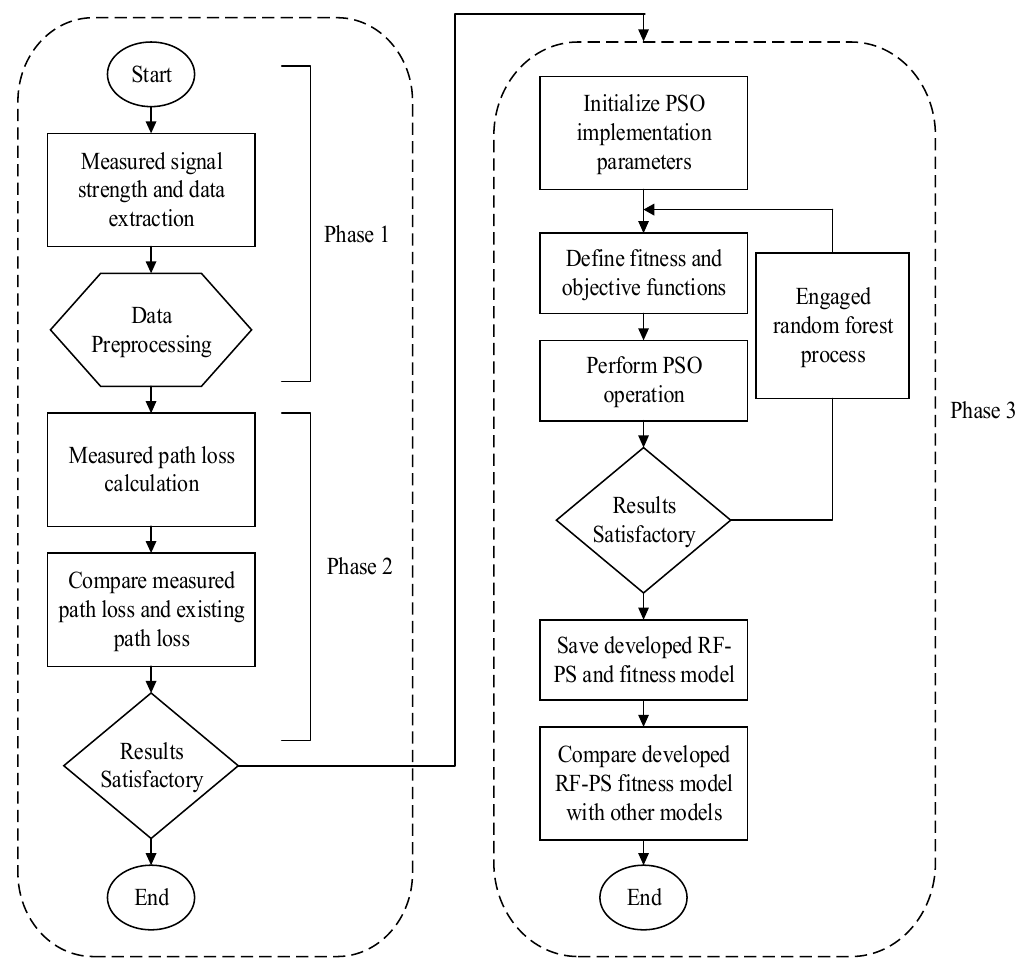
Figure 2. A three-phase flow chart for the proposed RF-PS path model development and application.